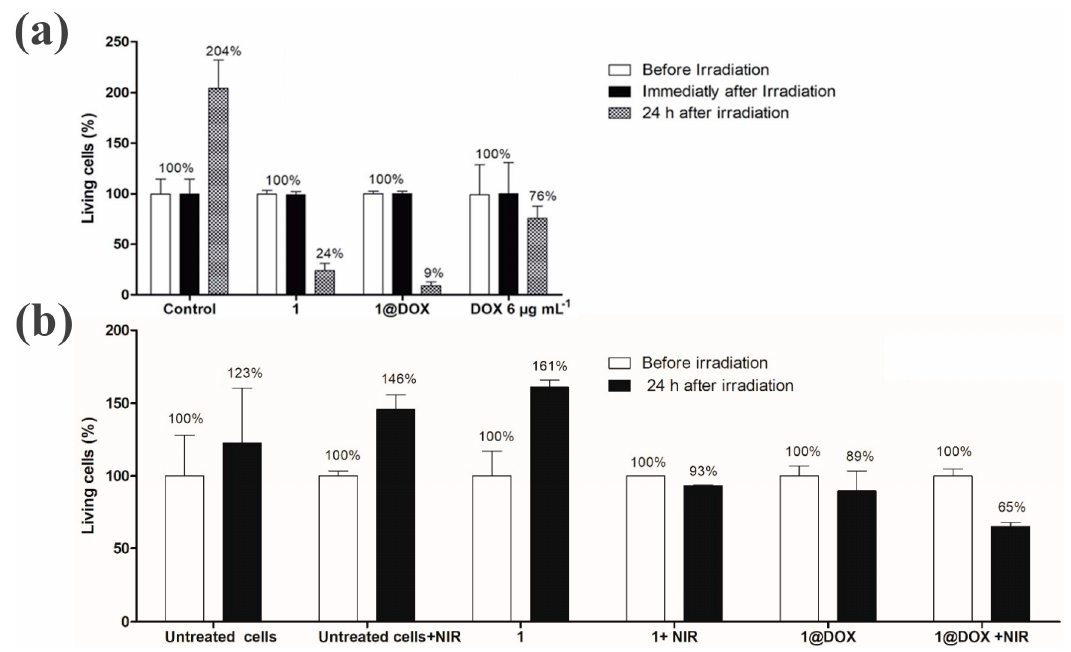
Figure 3. Cell counting (%) of living MDA-MB-231 cells treated with Mn 2 + -doped PBNPs@DOX (1@DOX) and Mn 2 + -doped PBNPs (1) at 50 mg / mL and free DOX before irradiation and 24 h after irradiation with a TPE laser at 808 nm (3.7 W, 5% of total laser power) for 10 min ( a ) and with SPE at 808 nm (2.5 W cm − 2 ) for 30 min ( b ), adapted with permission from ref. [95].